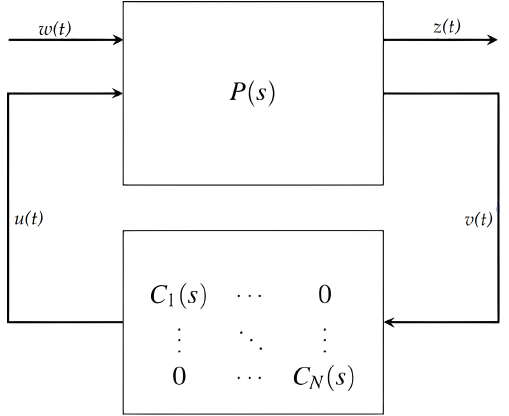
Figure 8. Standard formulation of the fixed-structured H ∞